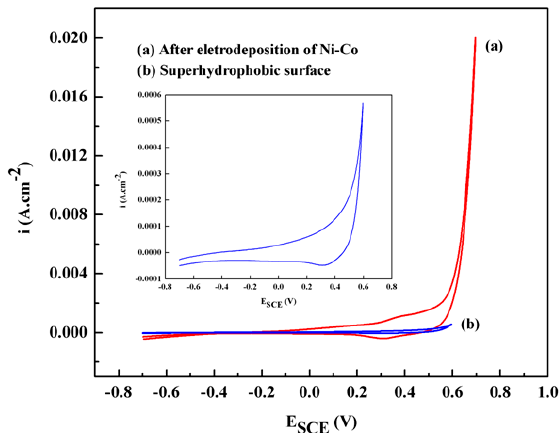
Figure 9. Cyclic voltammorgrams of bare AA5052 aluminum alloy and superhydrophobic surface in 0.1% NaOH solution.